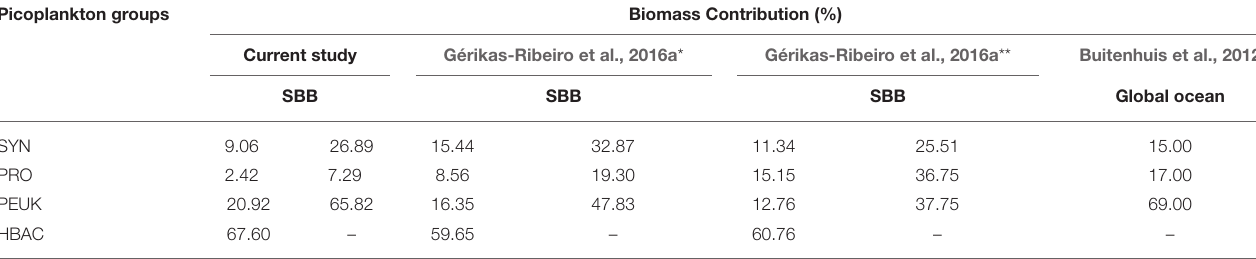
TABLE 3 | Comparison of picoplankton biomass contribution (%) for each group [ Synechococcus spp. (SYN), Prochlorococcus spp. (PRO), picoeukaryotes (PEUK), and heterotrophic bacteria (HBAC)] between the current study and Gérikas-Ribeiro et al. (2016a) and Buitenhuis et al. (2012) for the South Brazilian Bight (SBB) and global ocean,